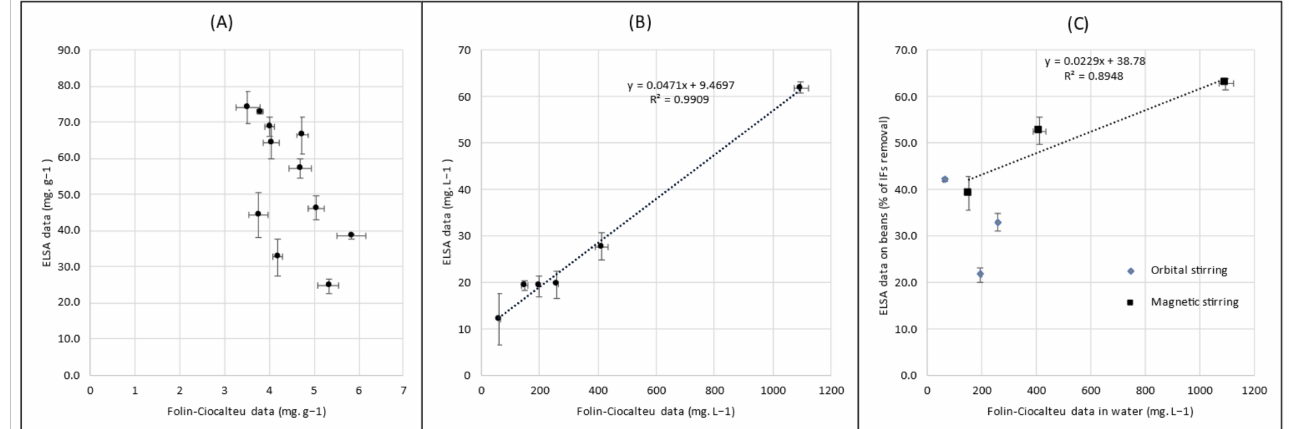
Figure 4. Comparisons between the ELISA and the Folin–Ciocalteu methods for isoflavone content determination: ( A ) in soybeans, a lack of correlation; ( B ) in water, the presence of correlation; ( C ) between IF removal from soybeans (ELISA) and polyphenols in water (Folin–Ciocalteu), the presence of correlation. Error bars are